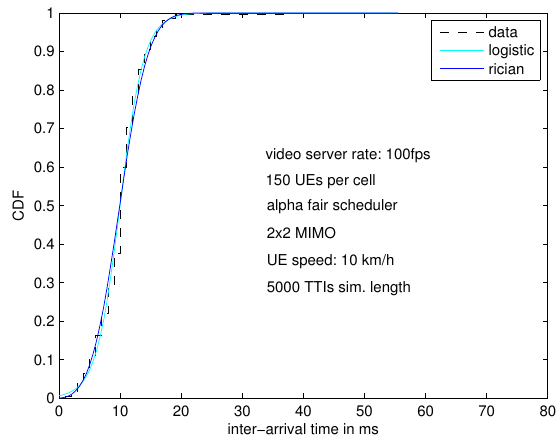
Figure 3: Cumulative distribution function of the inter-arrival